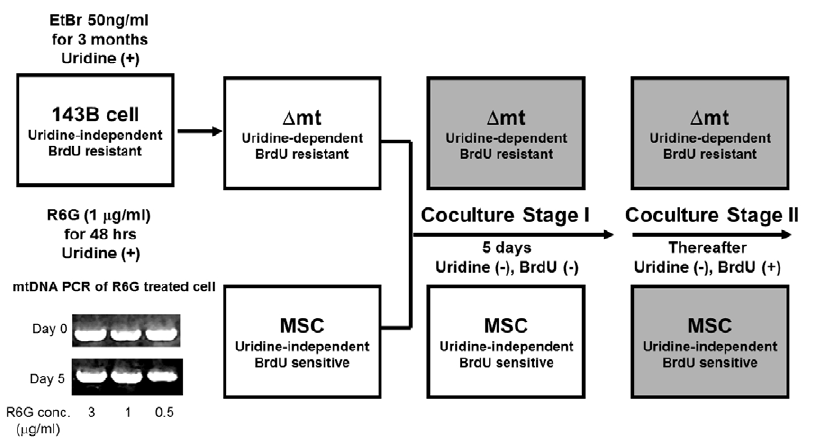
Figure 1. Scheme of coculture experiments. Mitochondrial dysfunction was induced by long-term treatment of ethidium bromide (EtBr), which is known to remove mtDNA while sparing nuclear DNA, or by short-term treatment of rhodamine 6G (R6G), which tightly binds to the mitochondrial inner membrane and destroys the mitochondrial respiratory function. Gel image shows that the mtDNA was still present until five days after R6G treatment (inset). We cocultured MSCs with 143B-derived cells with severely compromised mitochondrial function ( D mt) in uridine 2 BrdU 2 media for five days (Stage I) and in uridine 2 BrdU + media thereafter (Stage II). Cybrid cells harboring either the A3243G or 4,977 bp deletion mutation were also cultured in a similar way, with slight modification. For details, refer to the Materials and Methods section. The gray-colored box refers to the condition, which was expected to be fatal for the cells.